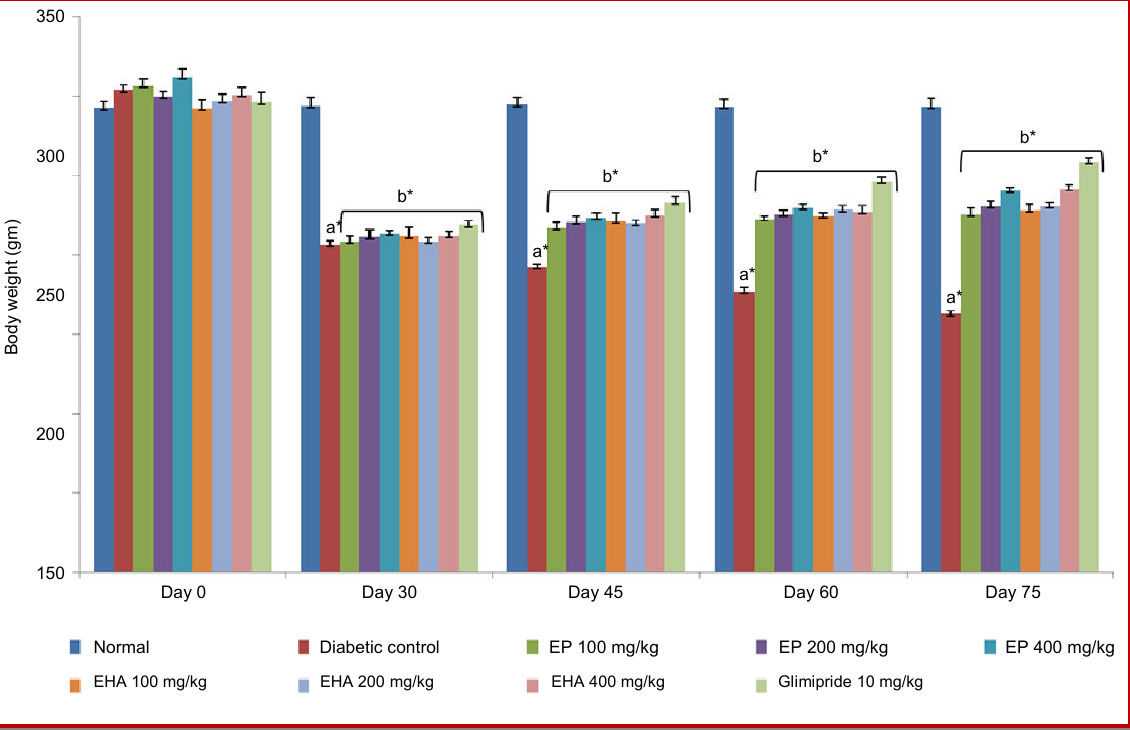
Figure 1: Effect of petroleum ether (EP) and hydroalcohol (EHA) extract on body weight. Data are mean ± SEM; n = 6; Data was ana- lyzed by using one- way ANOVA followed by Tukey’s multiple test; ‘a’ vs control, ‘b’ vs diabetic control;